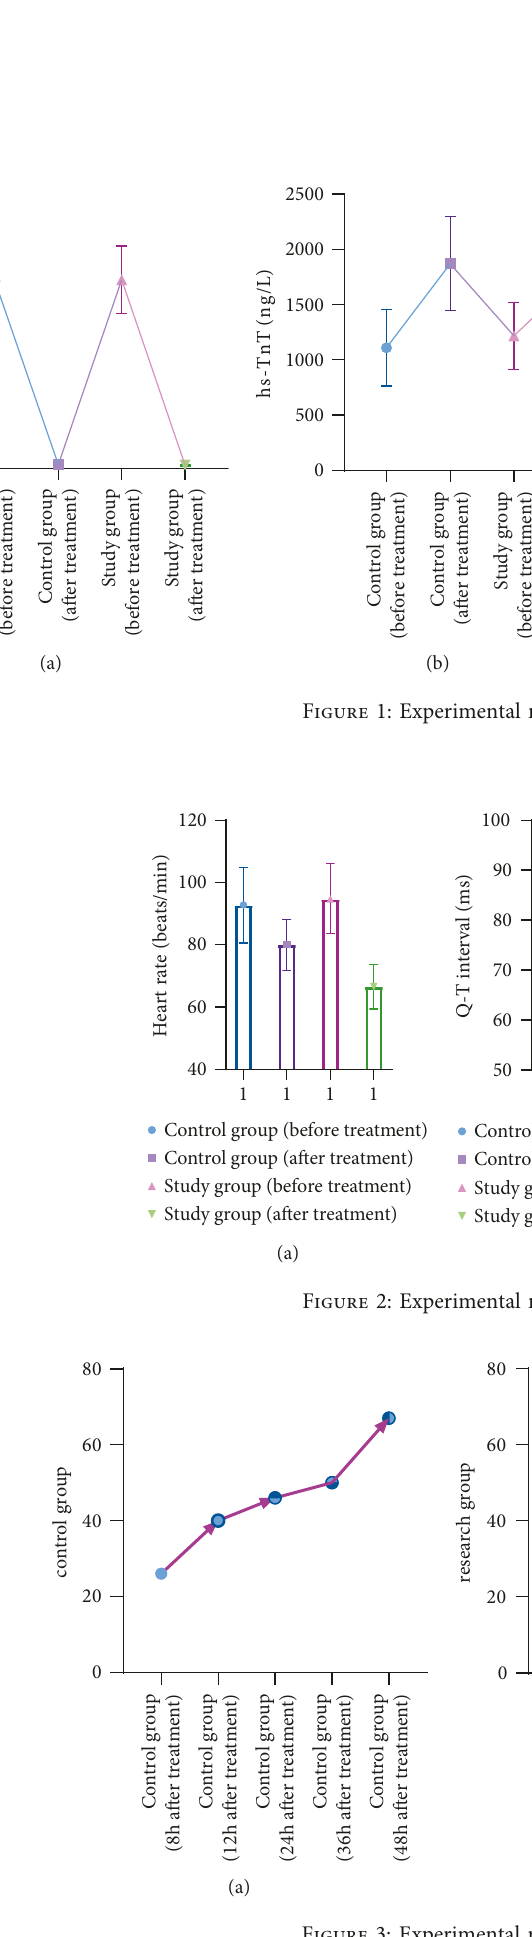
Figure 3: Experimental